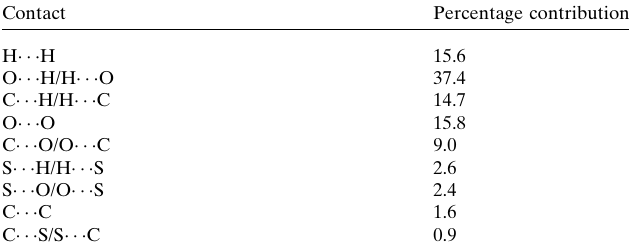
Table 3 Percentage contributions of interatomic contacts to the Hirshfeld surface for (I).